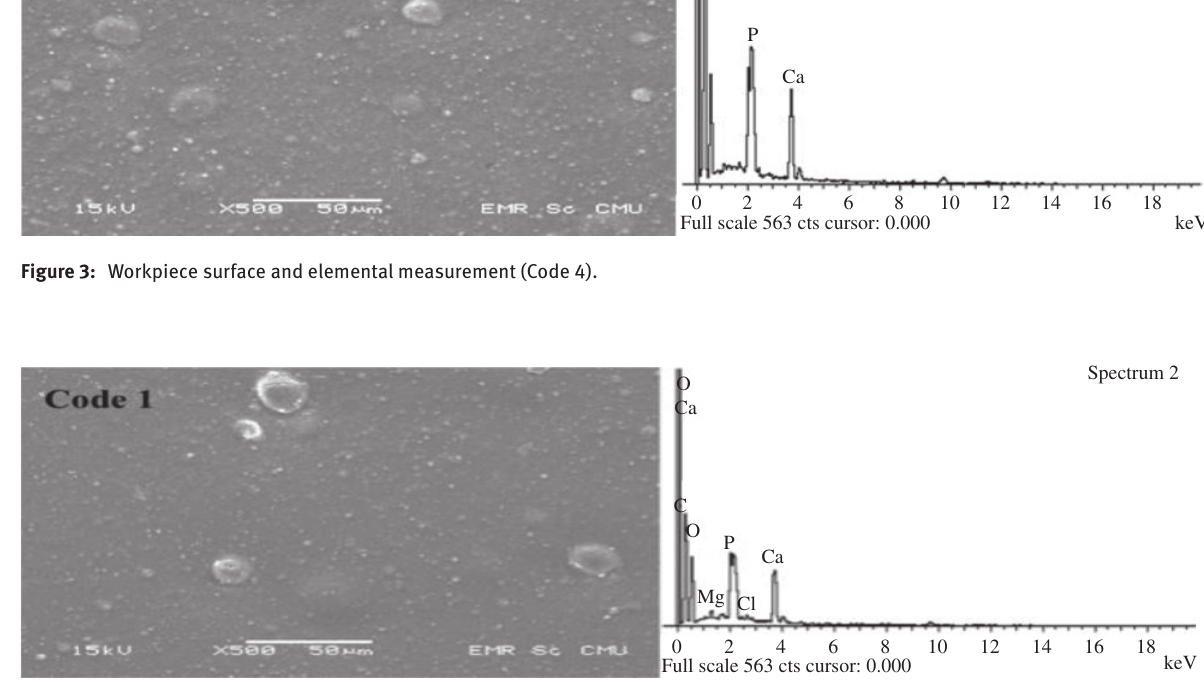
Figure 4: Workpiece surface and elemental measurement (Code